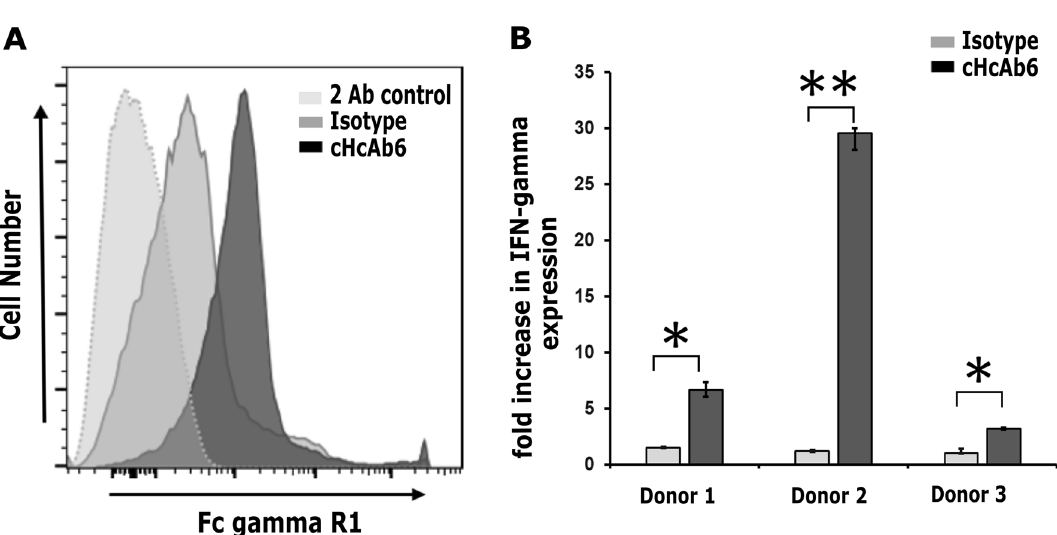
Figure 6. ( A ) cHcAb6 binds to cells expressing the canine FcγRI receptor. MDCK cells transiently expressing FcγRI were stained with cNb6, and bound cHcAb6 was detected using anti-Fc-750 antibody by flow cytometry. Canine IgG and cells stained with secondary Ab only were used as controls. ( B ) cHcAb6 induces IFN-γ expression from PBMCs after CD3 stimulation. CPBMCs were stimulated with 1 μg/mL of anti-CD3 antibody in the presence or absence of 100 nM of cHcAb6. After 72 h, IFN-γ expression was quantified using TaqMan assays. HRPT1 was used as endogenous control, and expression levels of IFN-γ were normalized to CD3 stimulated PBMCs. All experiments were performed in